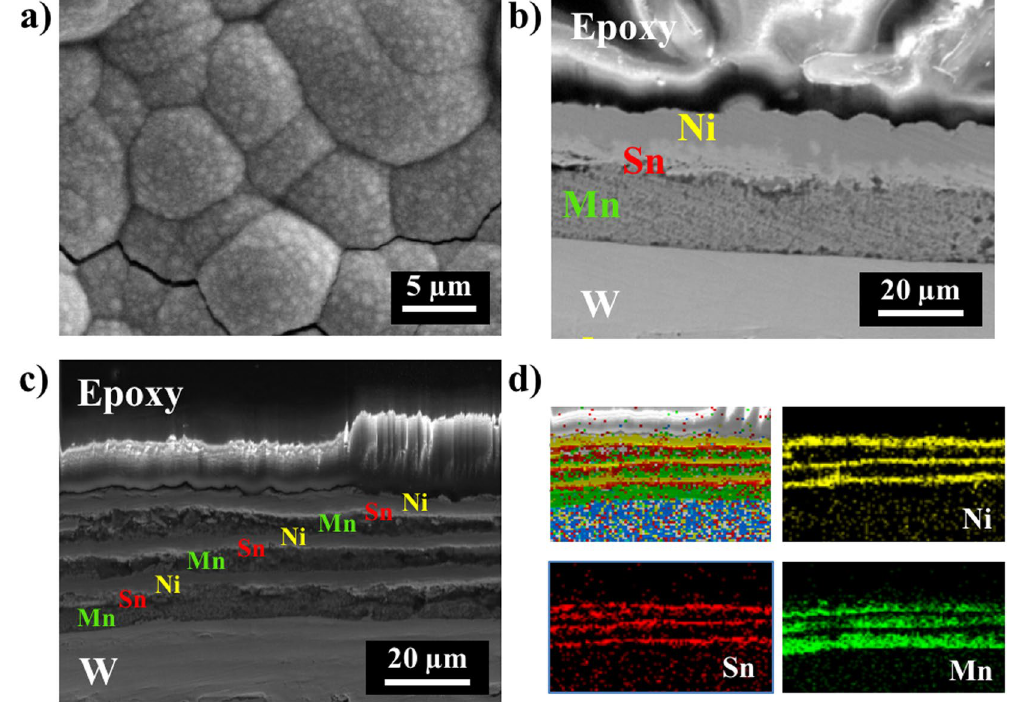
Figure 4. ( a , b ) Single triplet ( n = 1) and ( c , d ) three triplet ( n = 3) of Ni 0.5 Mn 0.369 Sn 0.131 film before annealing. ( a ) Topography of film surface. ( b , c ) SEM image of film cross-sections, and ( d ) Ni (yellow), Sn (red), and Mn (green) compositional analysis by EDS.